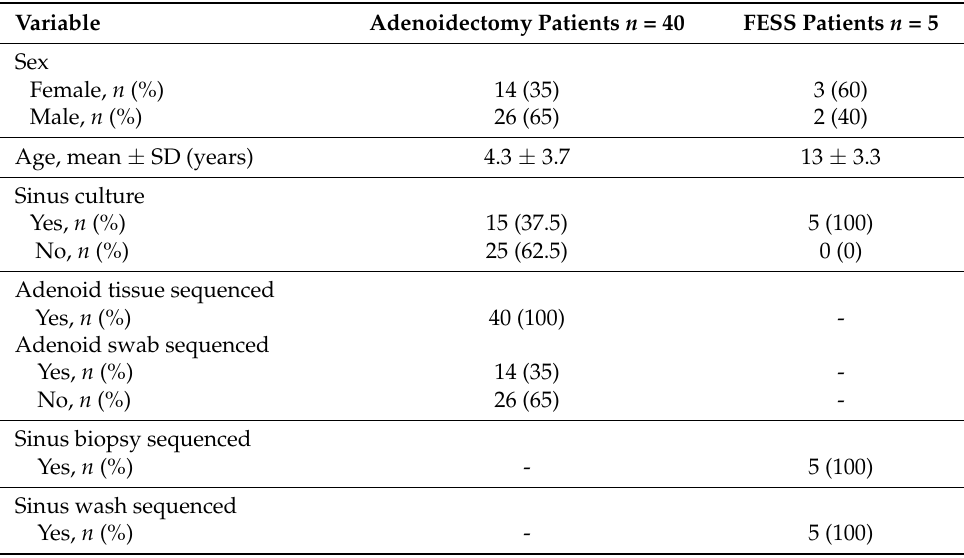
Table 1. Demographics of the study population in the Johns Hopkins All Children’s Hospital (JHACH) cohort. The cohort includes patients undergoing adenoidectomy and functional endoscopic sinus surgery (FESS). For numeric variables, the mean and standard deviation (SD) were calculated.